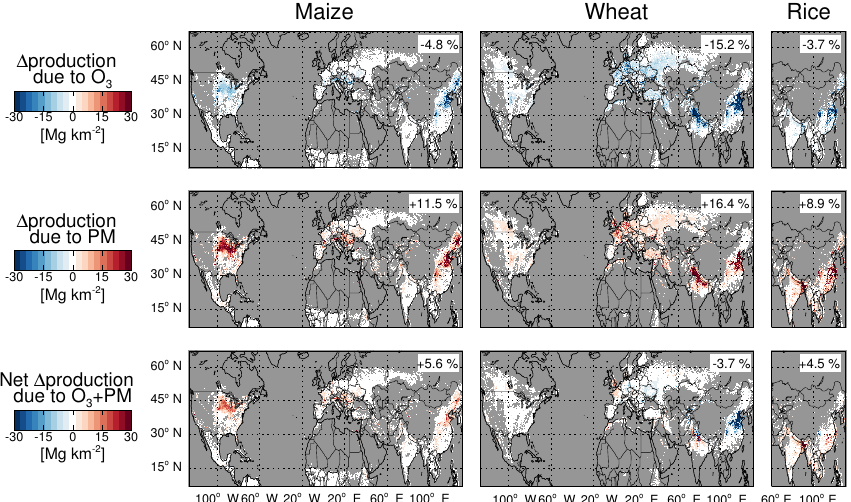
Figure 6. Change in crop production due to (top row) surface ozone, (middle row) PM with max (cid:49) RUE = 100%, and (bottom row) both ozone and PM. Sampled to growing season ending in 2010 for (left column) maize, (middle column) wheat, and (right column) rice. Filtered for base crop production greater than 0.01Mgkm − 2 . Global relative production change shown in upper right of each map. Relative change calculated from GAEZ 2010 base production adjusted for 2010 PM and ozone production impacts.